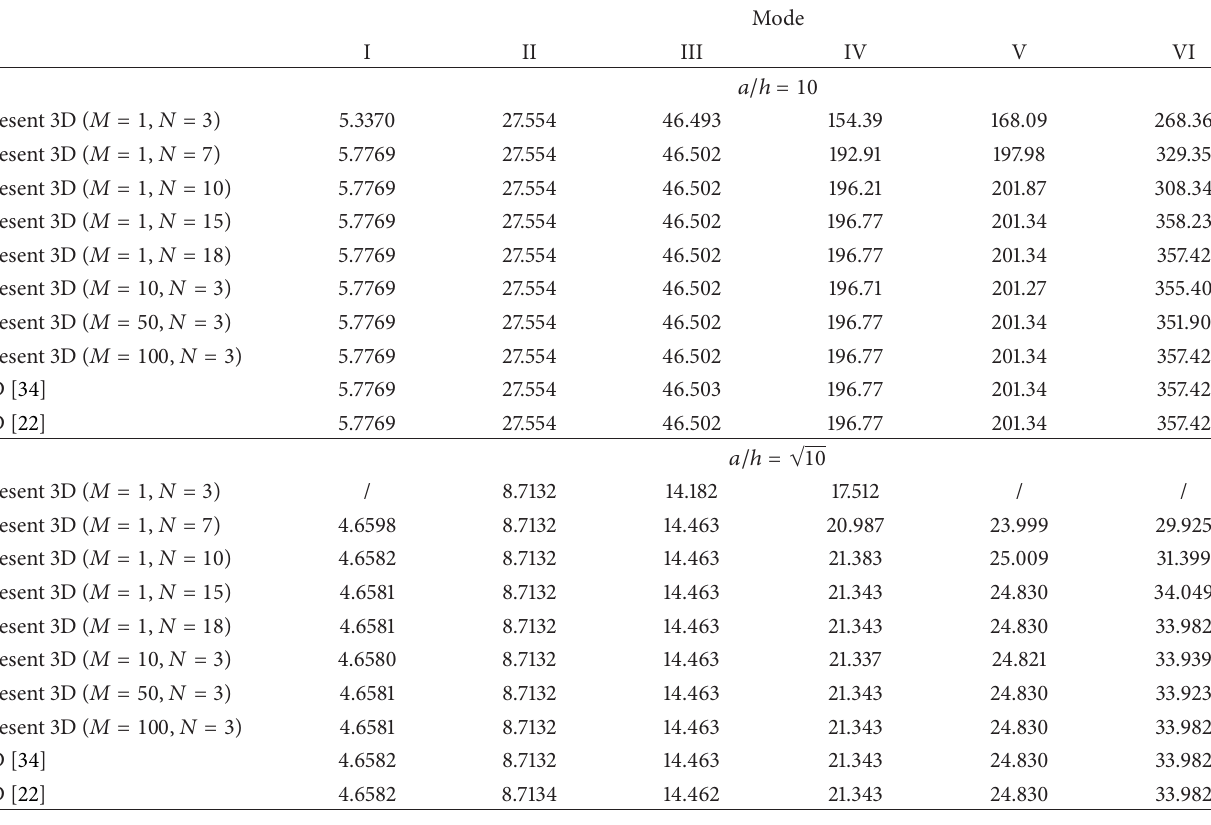
Table 1: Assessment 1. Simply supported aluminum square plate with Poisson ratio ] = 0.3 . First six exact natural circular frequencies in no- dimensional form 𝜔 = 𝜔(𝑎 2 /ℎ)√𝜌/𝐸 for imposed half-wave numbers 𝑚 = 𝑛 = 1 . Comparison between present three-dimensional analysis and three-dimensional analyses by Vel and Batra [34] and Srinivas et al. [22]. 𝑀 is the number of fictitious layers and 𝑁 is the order of expansion for the exponential